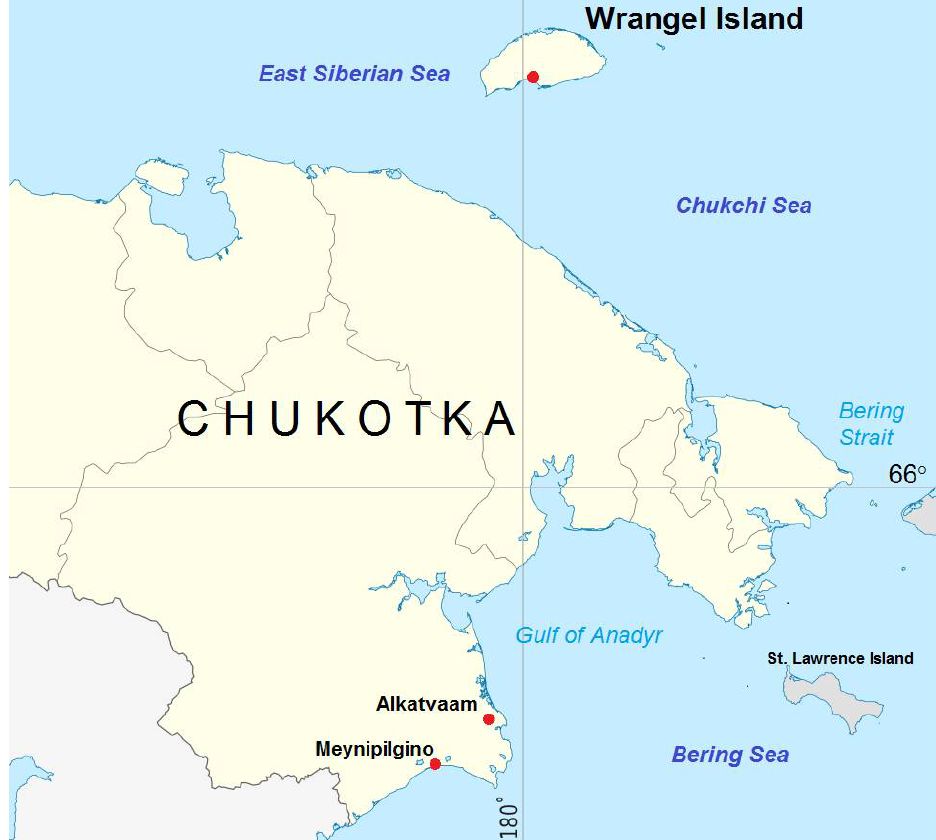
Figure 1. Map of collection localities of Pterostichus mandibularoides in Chukotka and on Wrangel Island (red points). The list of sequences is presented in Table S1. Ground beetles were preserved in 96% ethanol or dried after collection at room Table 1. Collecting localities and samples of Pterostichus mandibularoides from the northeastern edge of